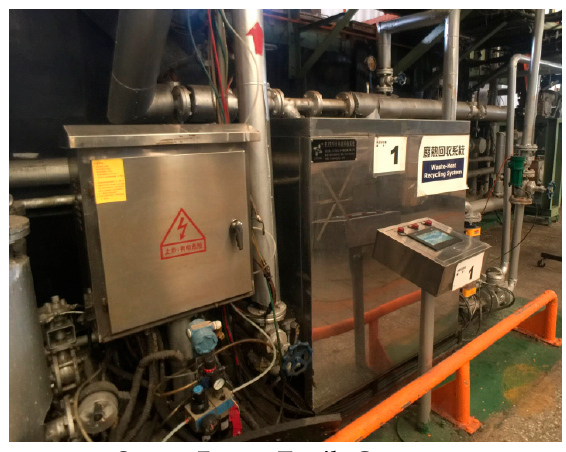
Figure 7. Waste-heat Recycling System.